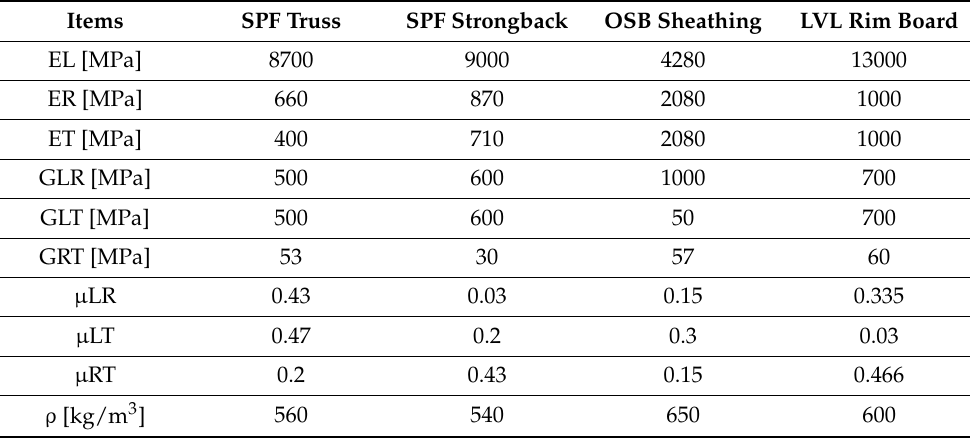
Table 4. Model parameters of the engineered wood